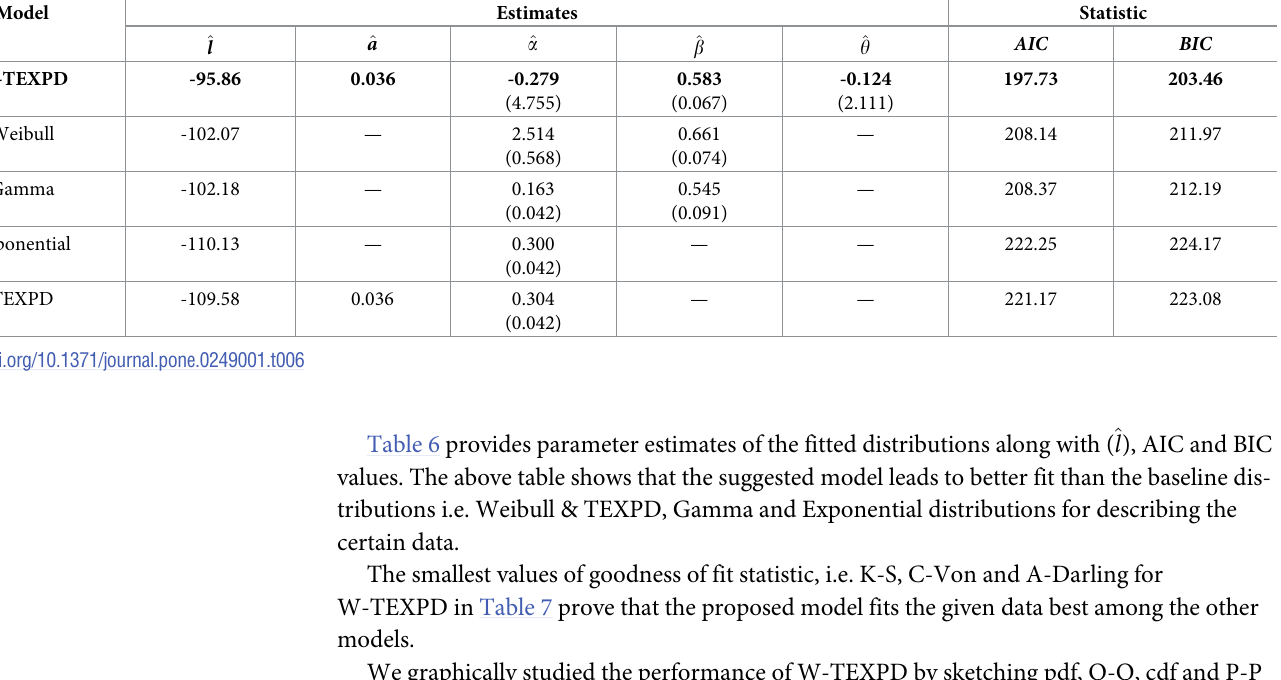
Table 5. Descriptive statistics of failure times of 50 components (per 1000 hours). Table 6. Negative log-likelihood values ( ^ ‘ ), MLEs of model parameters, the corresponding SEs (given in parentheses) and the statistics AIC and BIC of failure time of 50 components (per 1000 hours). Model